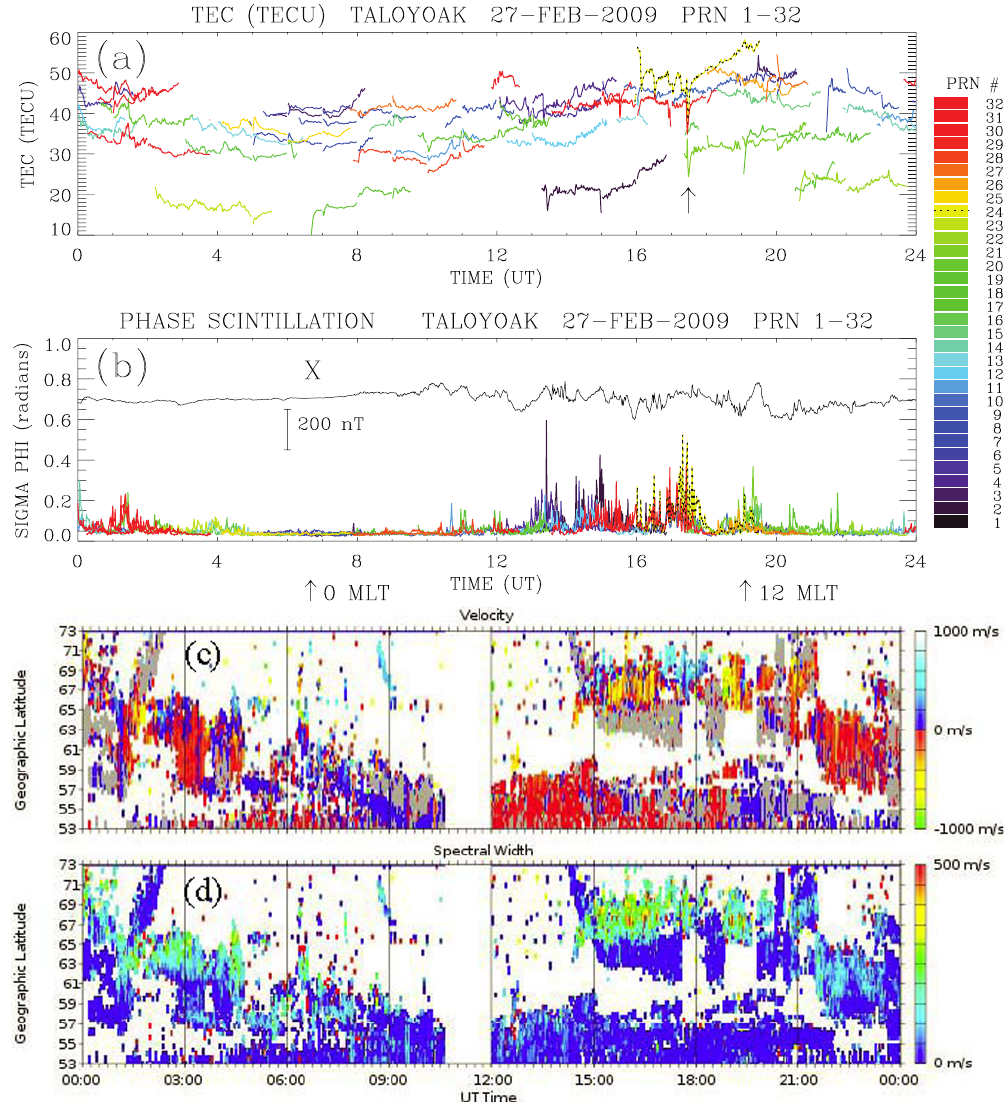
Fig. 3. (a) TEC, (b) phase scintillation index σ 8 observed in Taloyoak, the Saskatoon radar beam-5 (c) line-of-sight velocity, and (d) spectral width. The arrow in the top panel points to a TEC depletion that was associated with the flow channel shown in Fig. 4. The ground magnetic field X component is